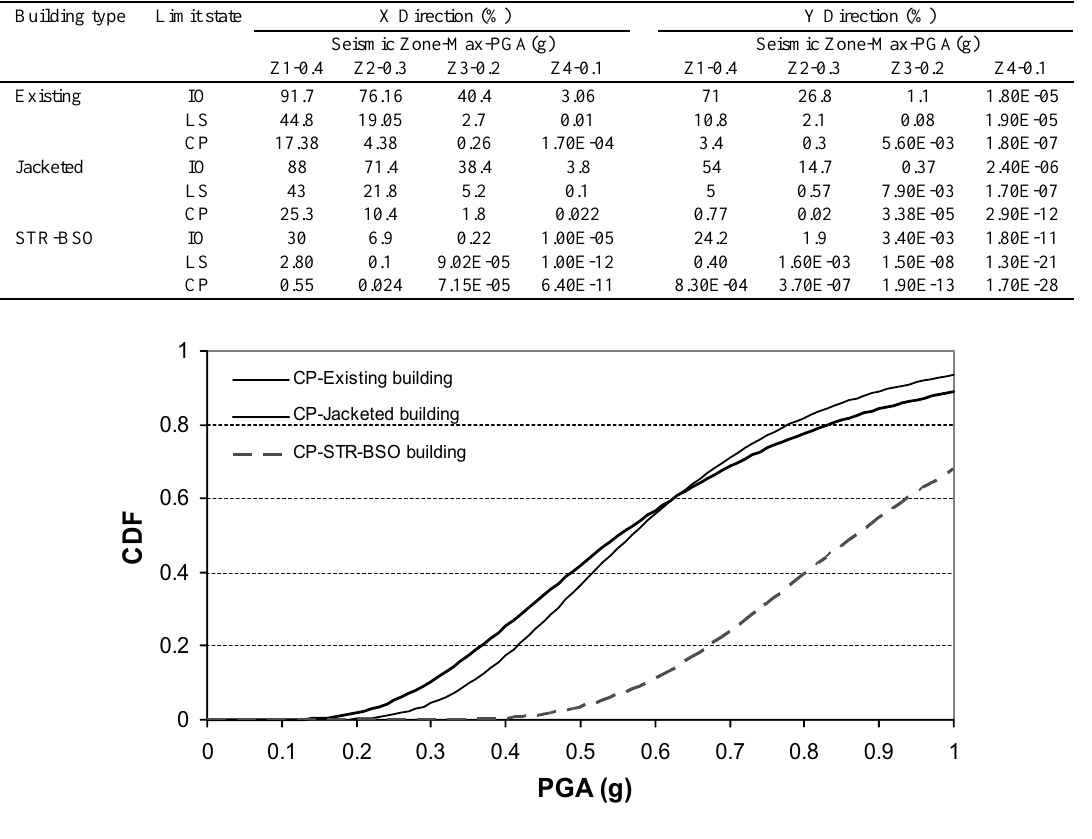
Fig. 7. Fragility curves for three buildings at X